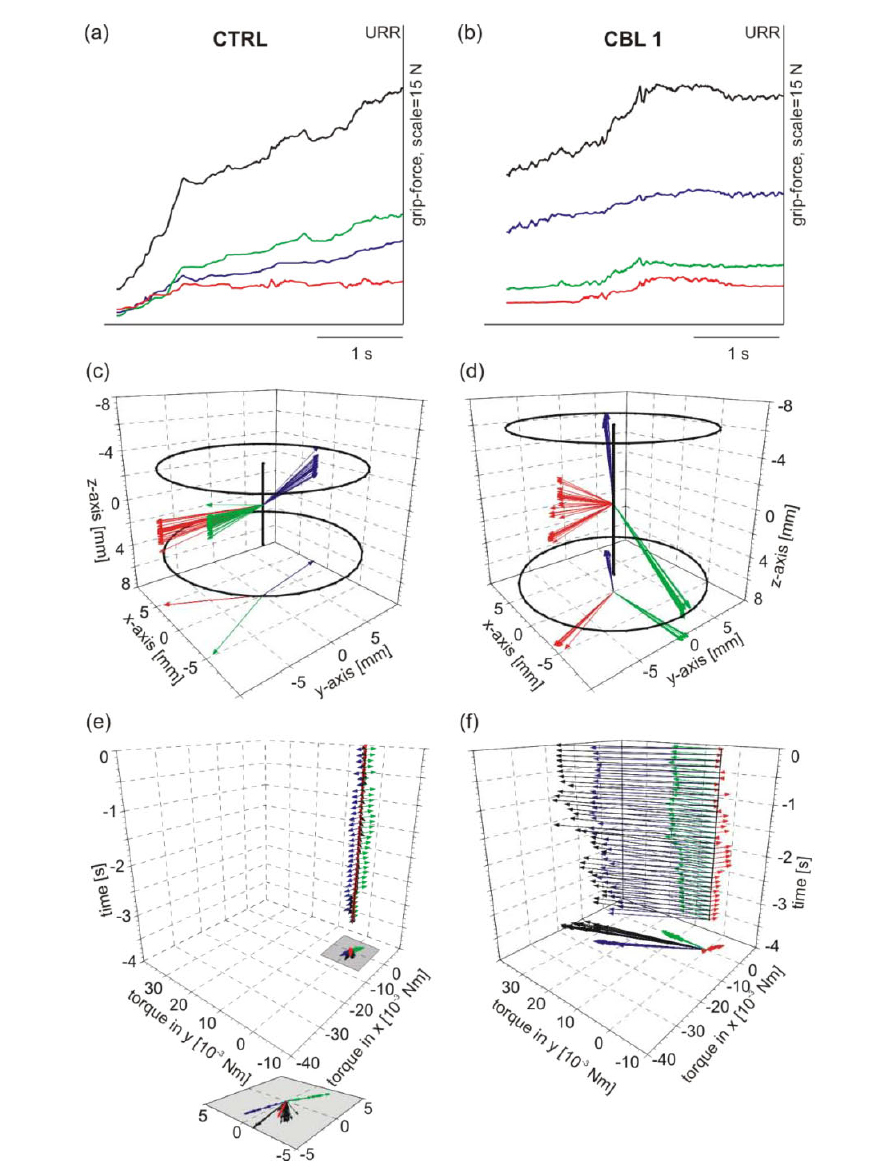
Figure 4. Dynamic torque development of a healthy subject (CTRL, left column) and a cerebellar patient (CBL 1, right column). (a, b) Grip force development of individual finger grip forces and total grip force (black line); same data as in Figure 3 b,c. (c, d) Levers of individual fingers. (e, f) Development of individual finger torques and total torque (black vectors). The inset in Figure 4e shows the extension of the projected torque vectors shown in the grey area. For a-f: colour convention as in Figure